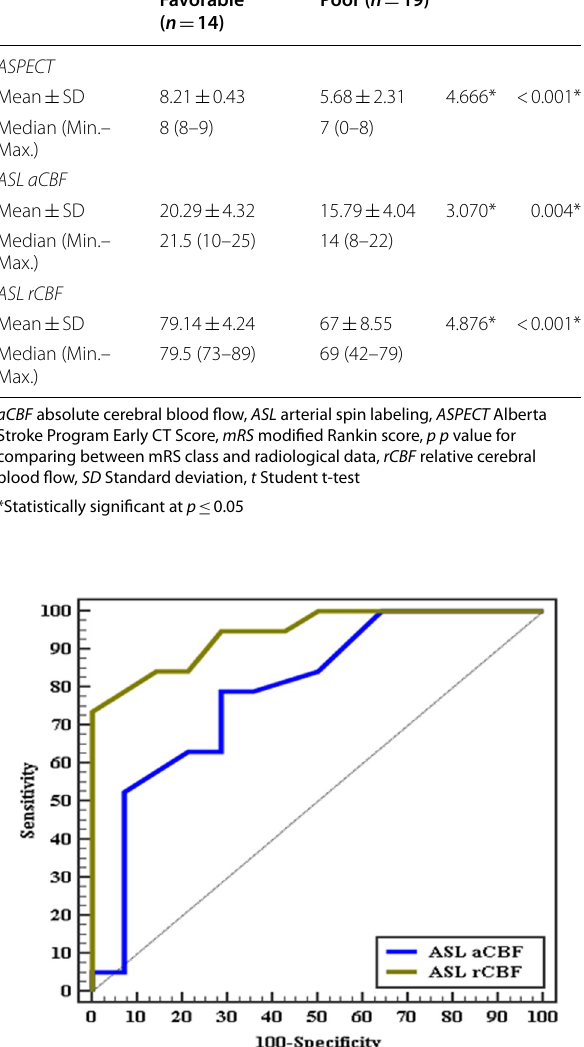
Fig. 5 ROC curve for ASL absolute CBF (aCBF) and relative CBF (rCBF) to predict the expected stroke outcome (mRS favorable or poor)